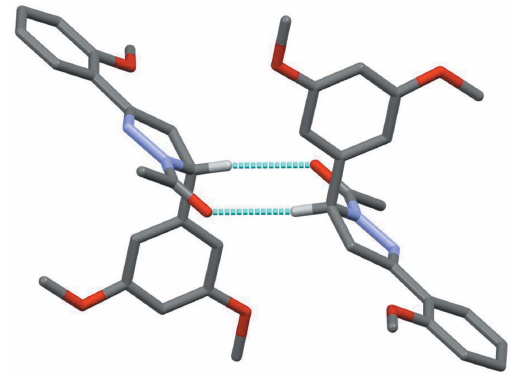
Figure 2 A view of the dimer formed by pairwise C—H (cid:3)(cid:3)(cid:3) O hydrogen bonds (dashed lines) in the crystal structure of the title compound. For clarity, only those H atoms involved in hydrogen bonding are shown.